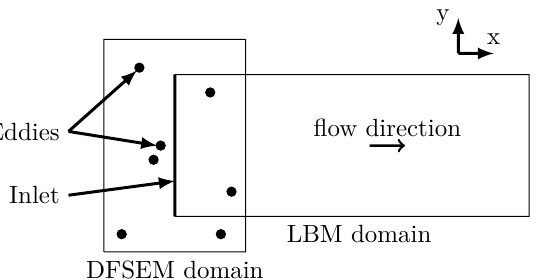
Figure 6. Working principle of the DFSEM in an LBM simulation.